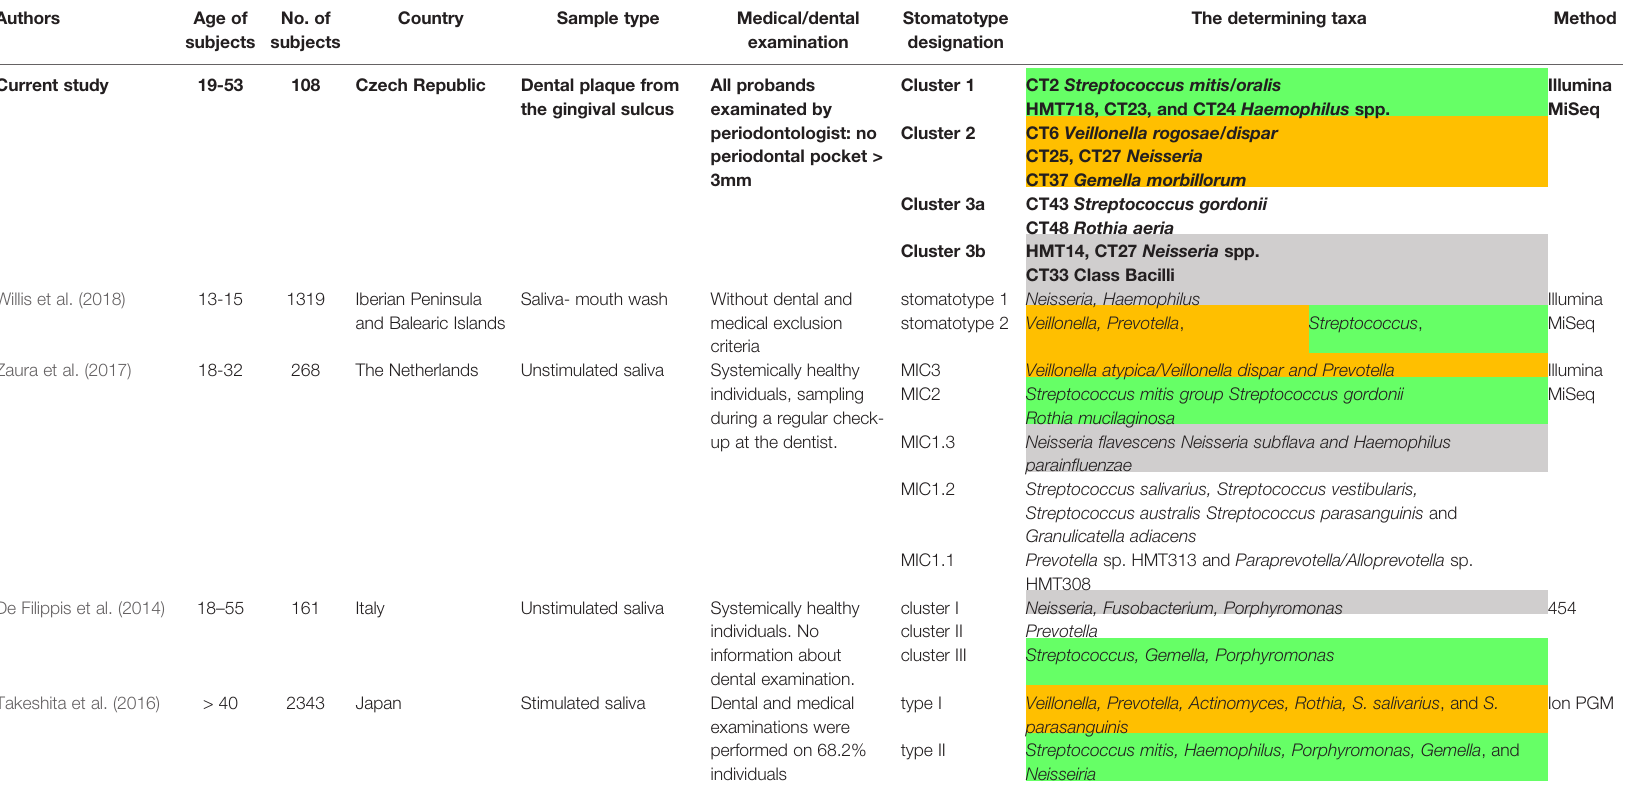
TABLE 3 | OM stomatotypes in periodontal